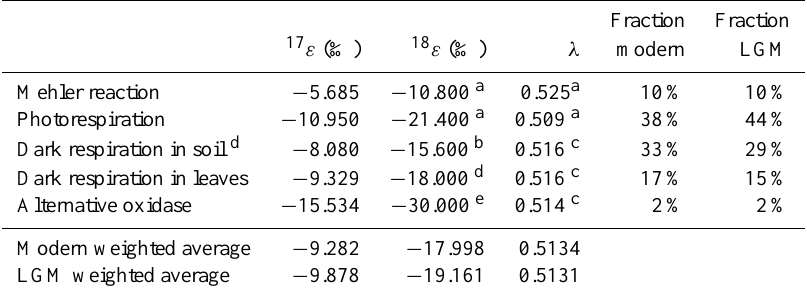
Table 1. Land respiration at present and during the LGM.